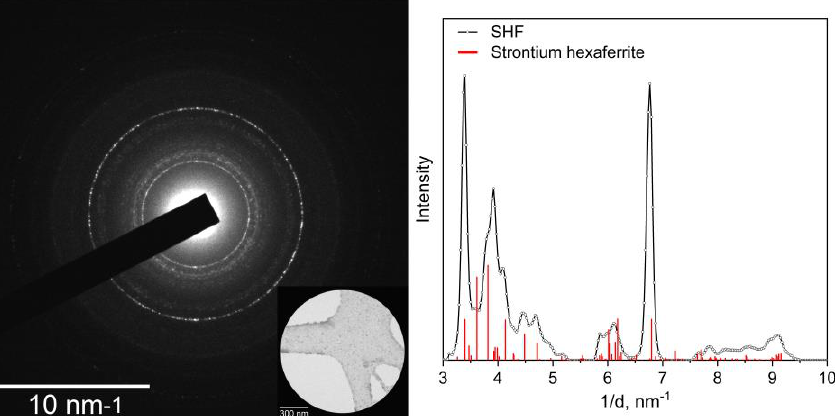
Figure A2. Particle diameter and thickness distributions of SHF sample obtained from TEM data.